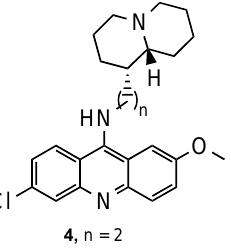
Figure 4. QN derivative 4 developed by Sparatore and co-workers [14].